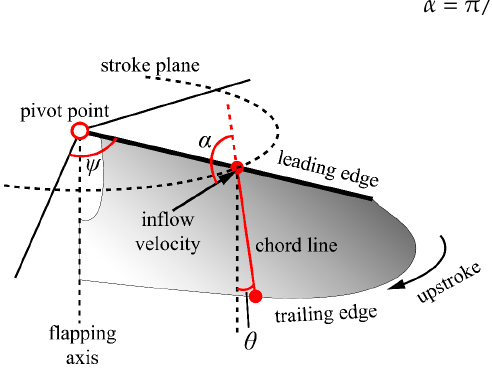
Figure 6. Definition of the flapping angle variables.